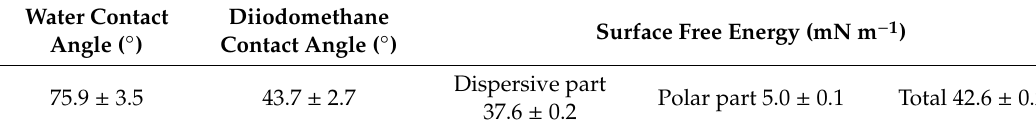
Table 6. Result of contact angle measurements of